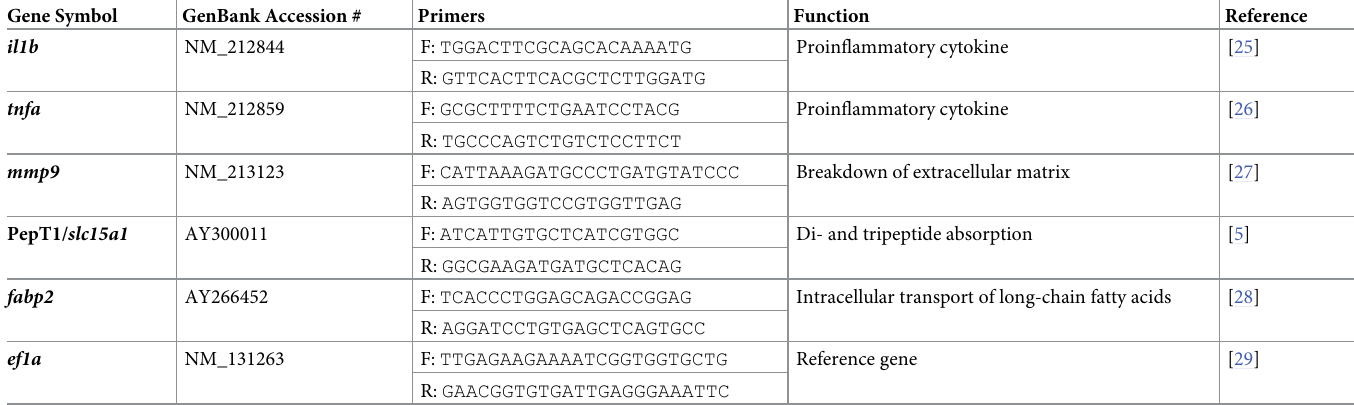
Table 2. Primers used for gene expression analysis. Gene